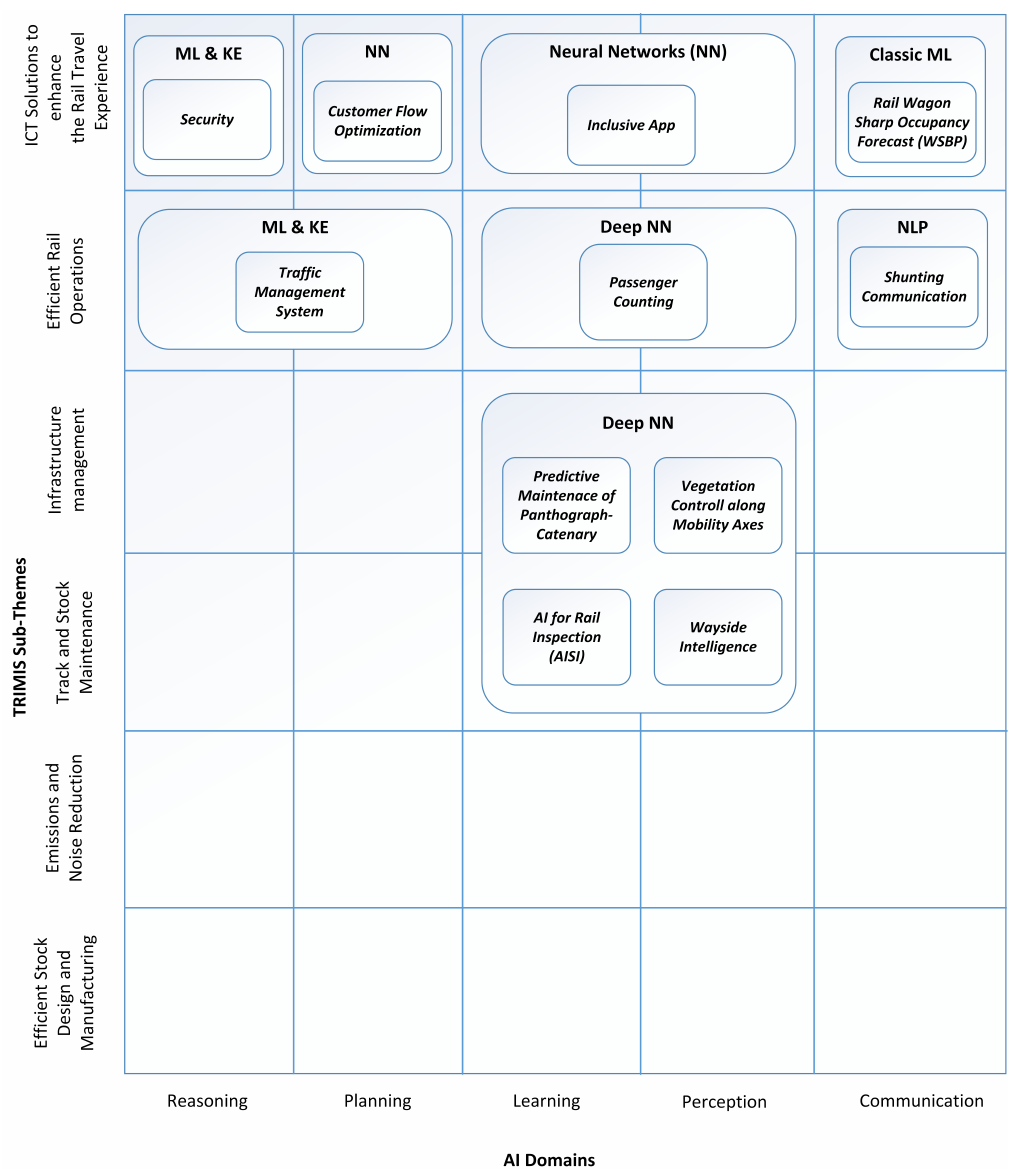
Figure 1. AI landscape in public